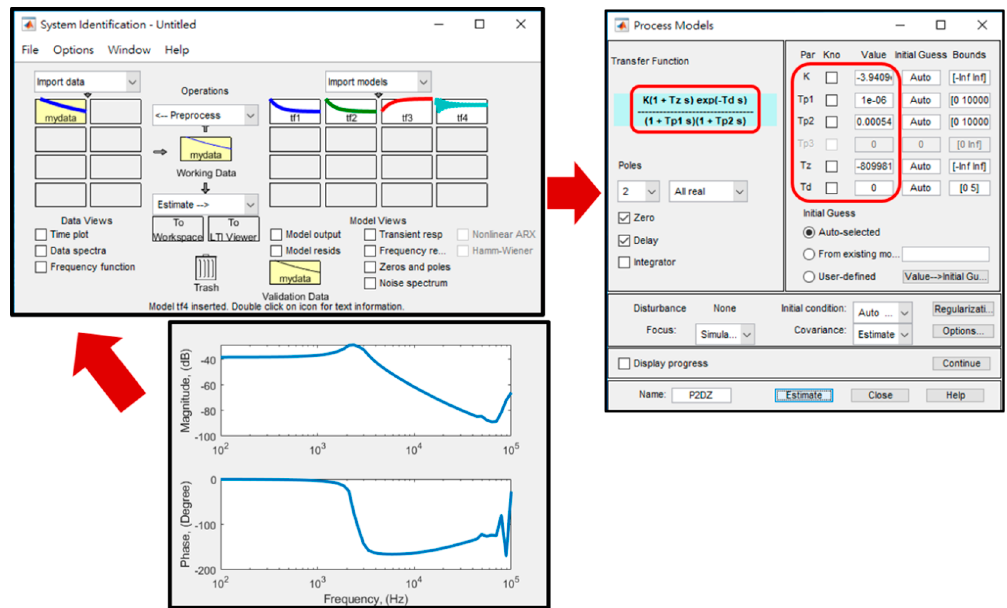
Figure 12. Processing flow windows of the system identification tool of MATLAB.